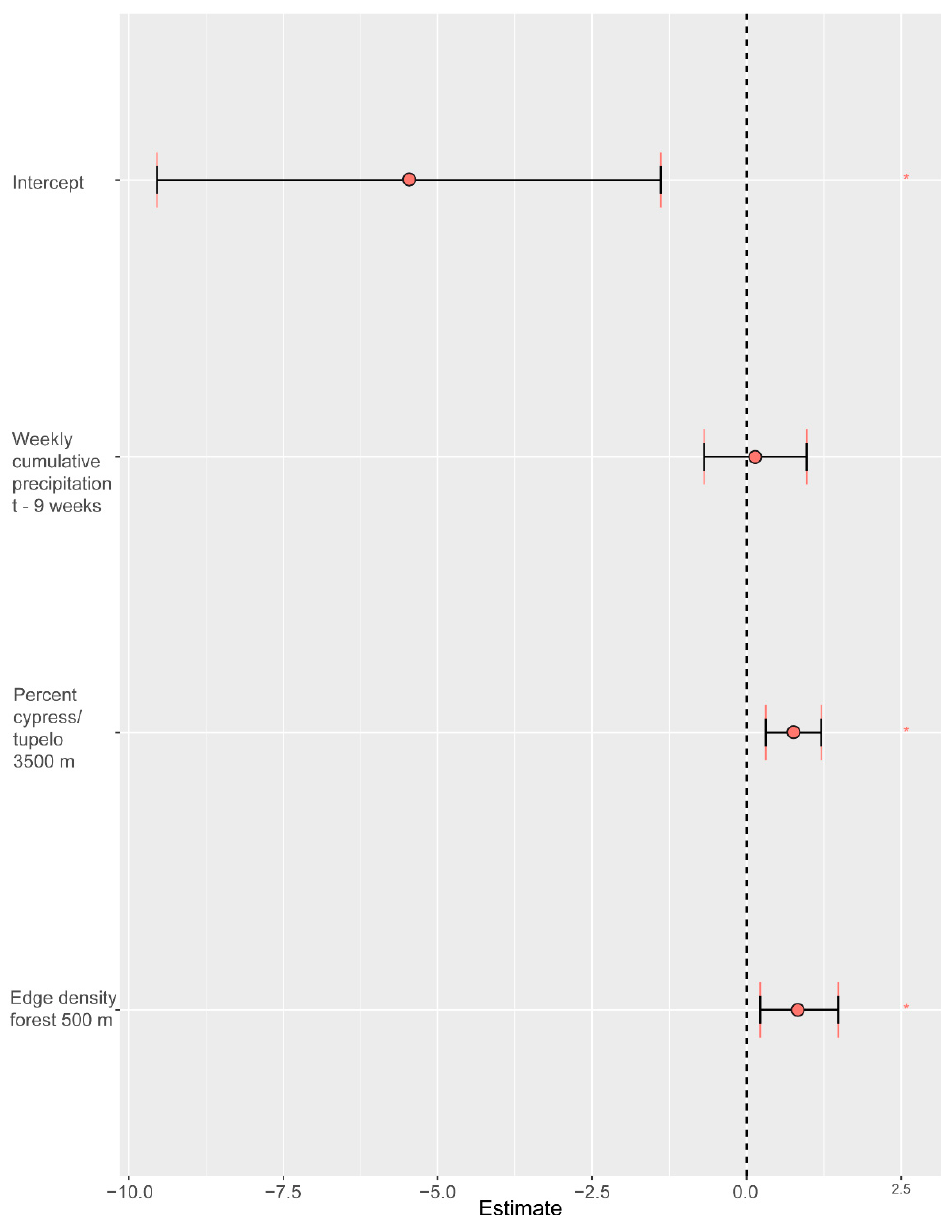
Figure 3. Effect curves of model parameters for environmental variables in the best-fitting EEEV model; credible intervals that do not cross zero indicate a strong positive or negative effect on EEEV seroconversion.